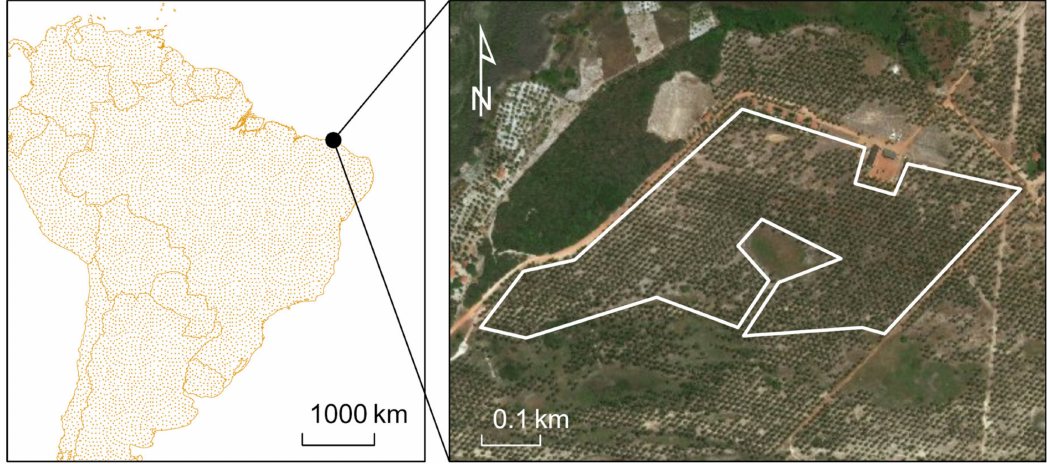
Figure 9. The Ceara domain in northern Brazil, with the study site highlighted in